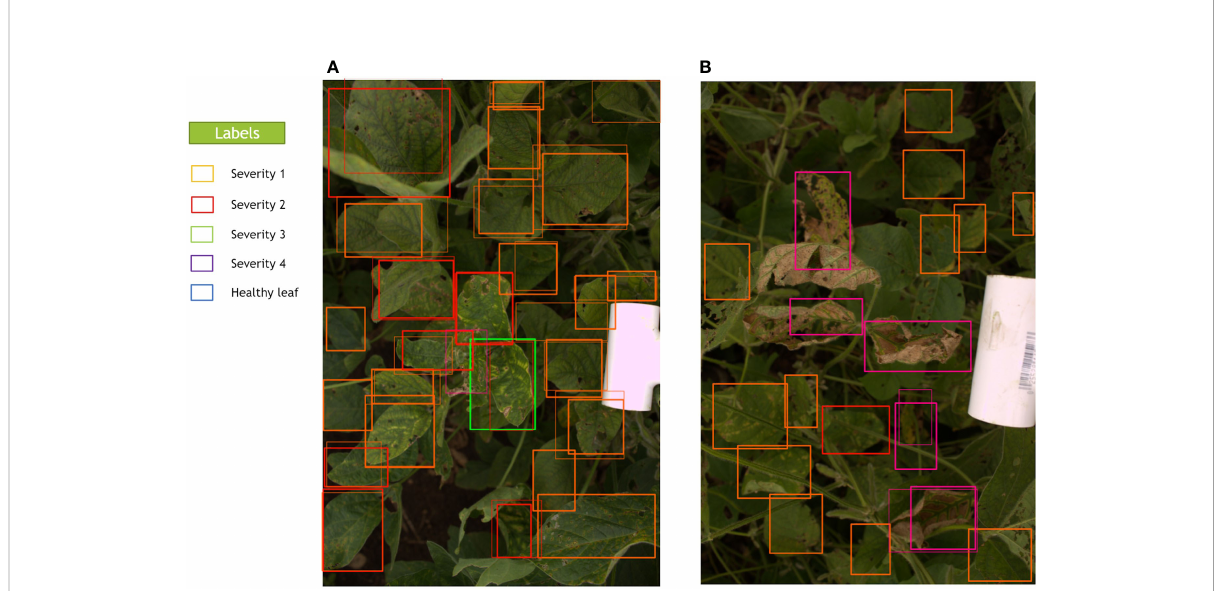
FIGURE 6 Predicted and ground truth bounding boxes for two random images (A, B) in the test set. Thick lines in these images show the predicted bounding boxes executed from the model, and thin lines show the ground truth bounding boxes. The model can also predict some unlabeled bounding boxes that were missed during data